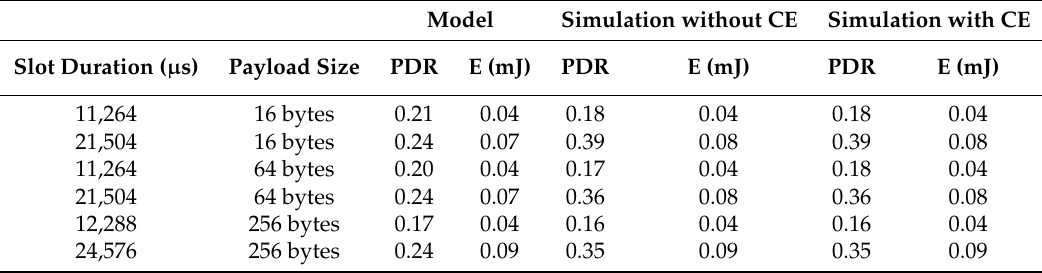
Table 7. Overview for 4 Mbps, 16 STAs per slot. Model Simulation without